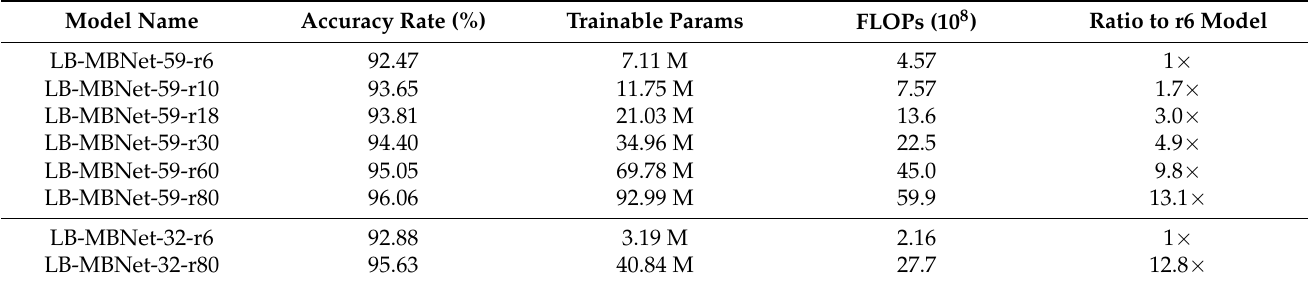
Table 2. Model recognition result with different expansion ratio r